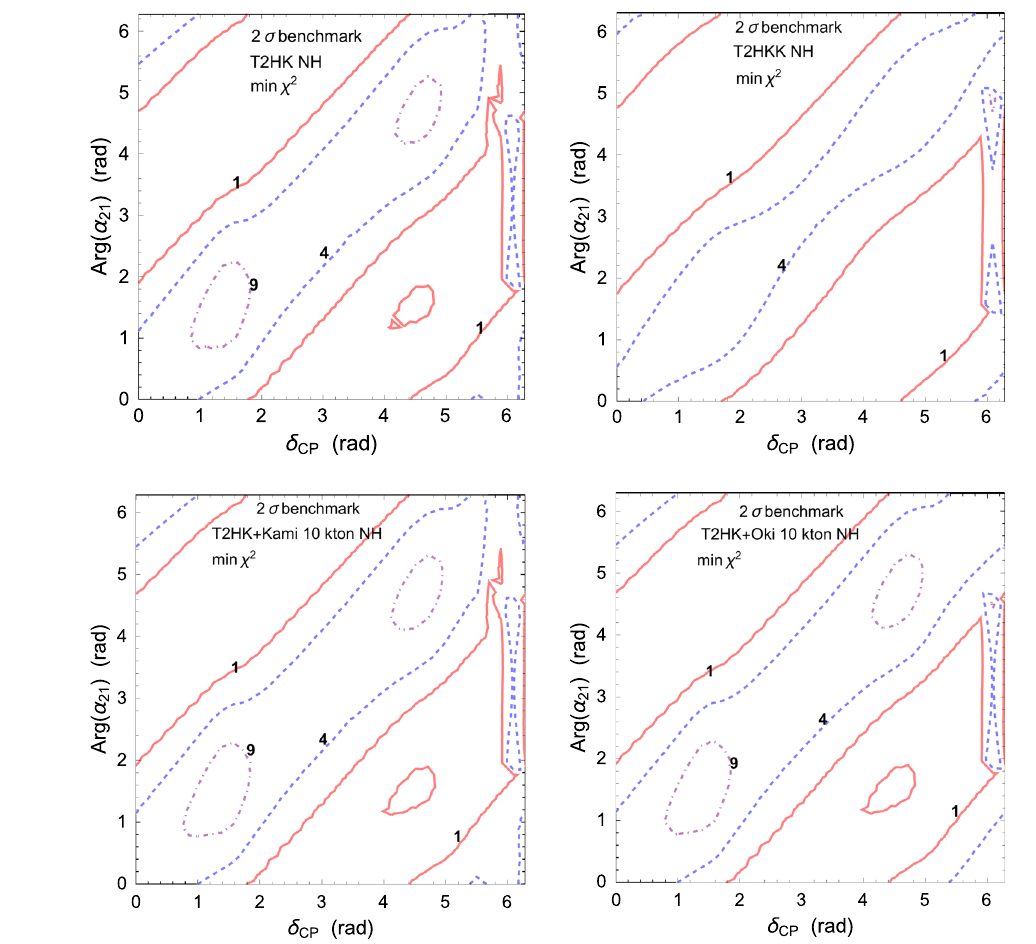
Fig. 11 The minimum of χ 2 ((cid:20)) Eq. (32), min χ 2 , on the plane of δ CP and Arg( α 21 ). The benchmark with Eq. (37) is assumed, and the true mass hierarchy is normal. The upper-left, upper-right and lower-right subplotscorrespondtotheT2HK,theT2HKK,andtheplanoftheT2HK plusa10ktonwaterCerenkovdetectoratOki,respectively.Forcompar-